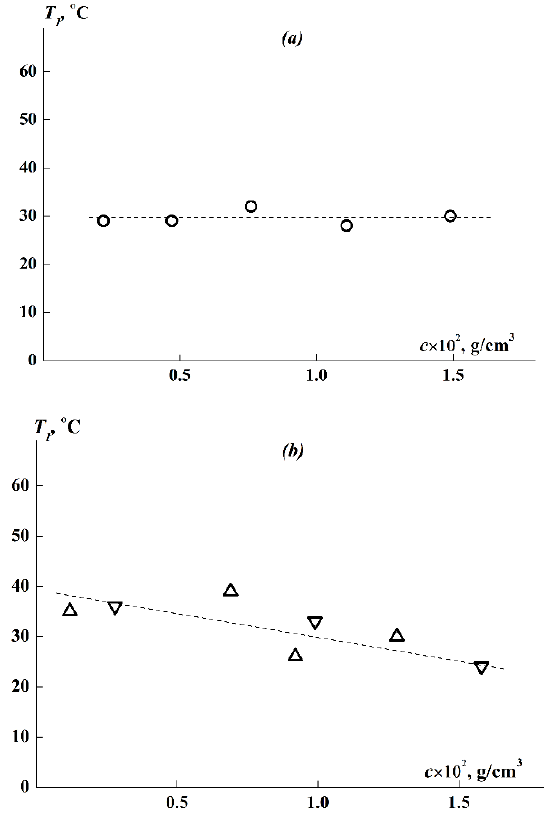
Figure 10. Concentrational dependence of phase separation temperatures for ( a ) sample 1 and ( b ) samples 2 (triangles) and 3 (inverted triangles) in APE O -g-PiPrOx aqueous solutions.